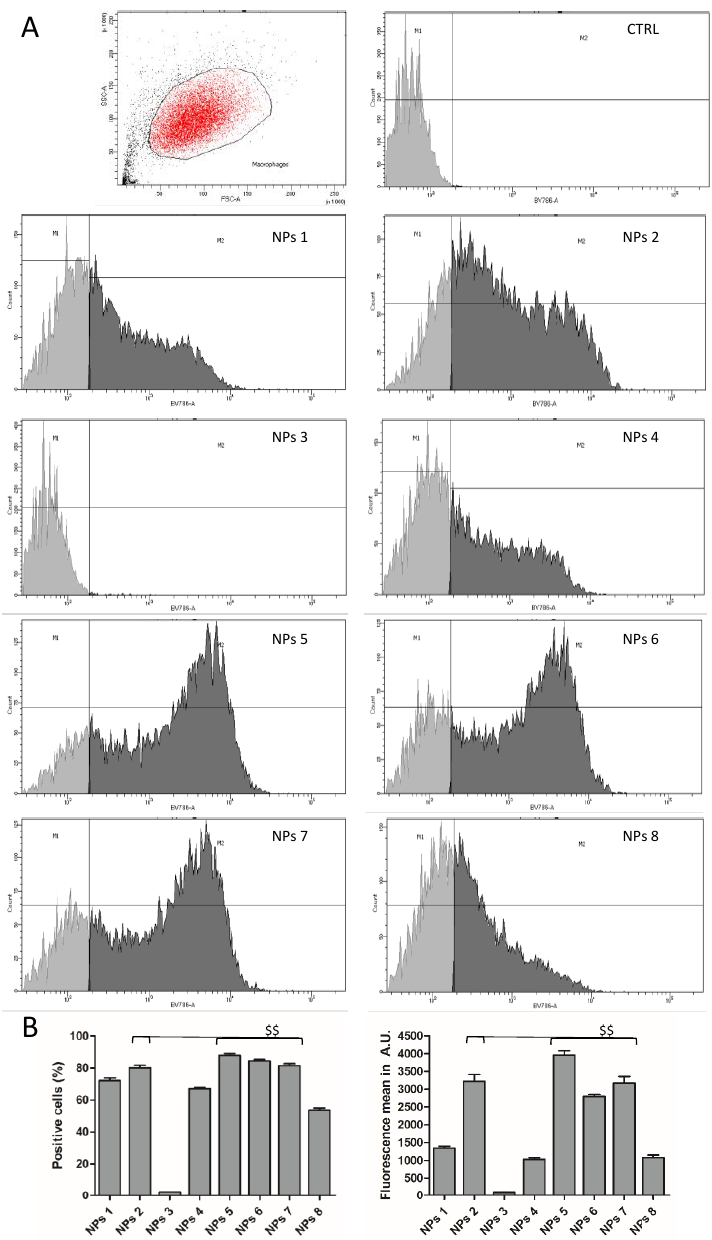
Figure 3. ( A ) Dot plot (control macrophages) and histograms used to detect negative (M1 gate) and positive (M2 gate) cells and determine the mean of fluorescence in control (CTRL) and cells incubated with NPs 1 to 8; ( B ) Quantification of percentages of positive cells and mean of fluorescence in macrophages incubated with PMLABe-based nanoparticles for 24 h. Statistical analyses: $$ < 0.01: highest percentages of positive cells or mean of fluorescence versus all the other conditions.